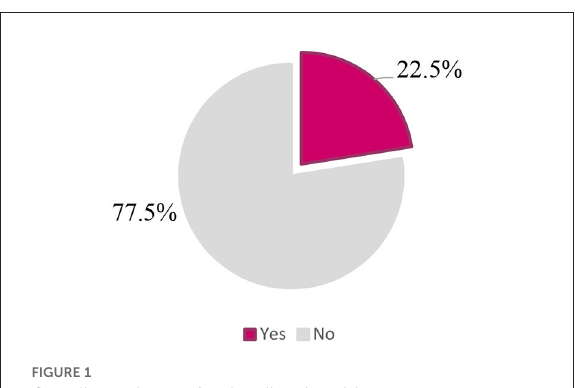
FIGURE1 Overall prevalence of eating disorders